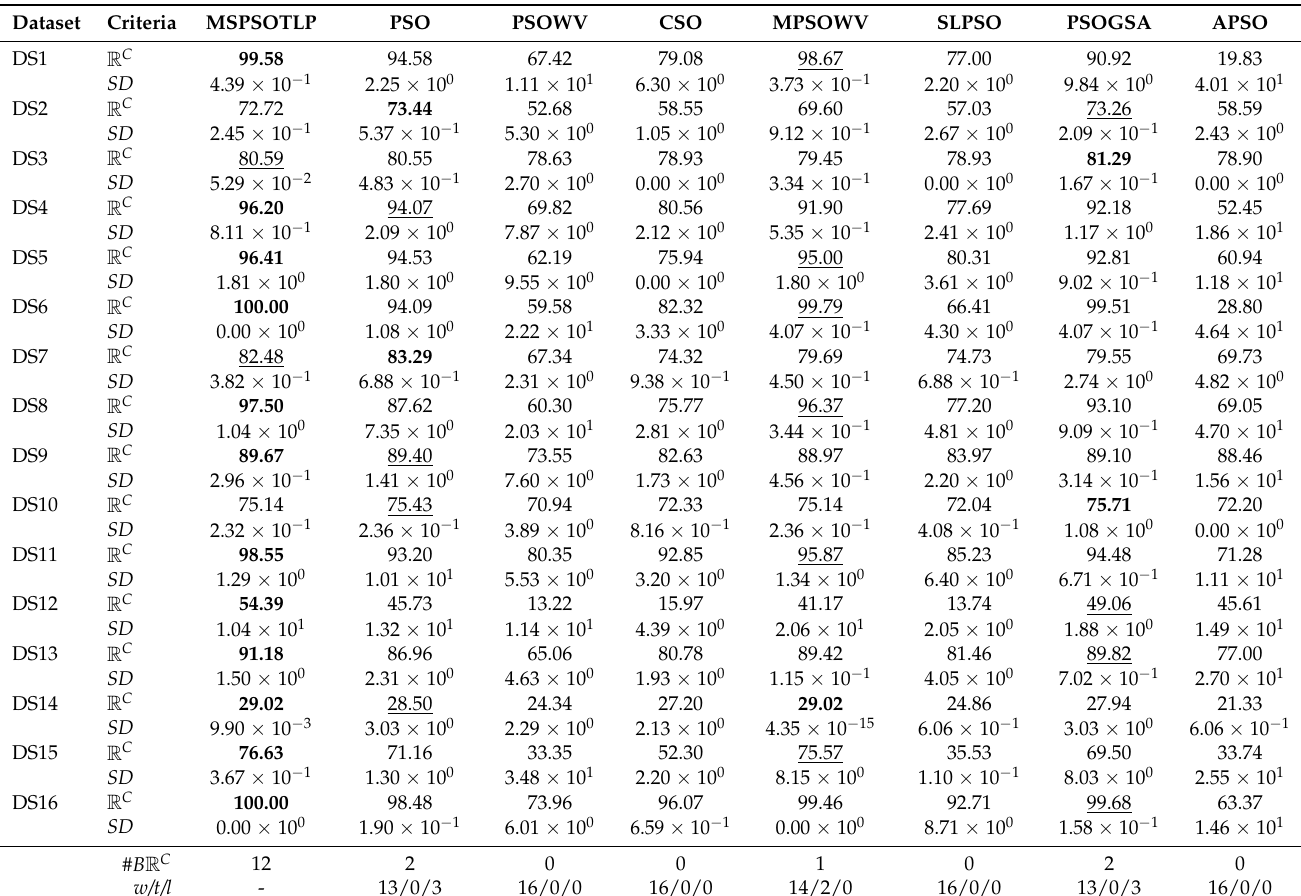
Table 11. The R C and SD values produced by ANN models trained by the proposed MSPSOTLP and other PSO variants when solving the training